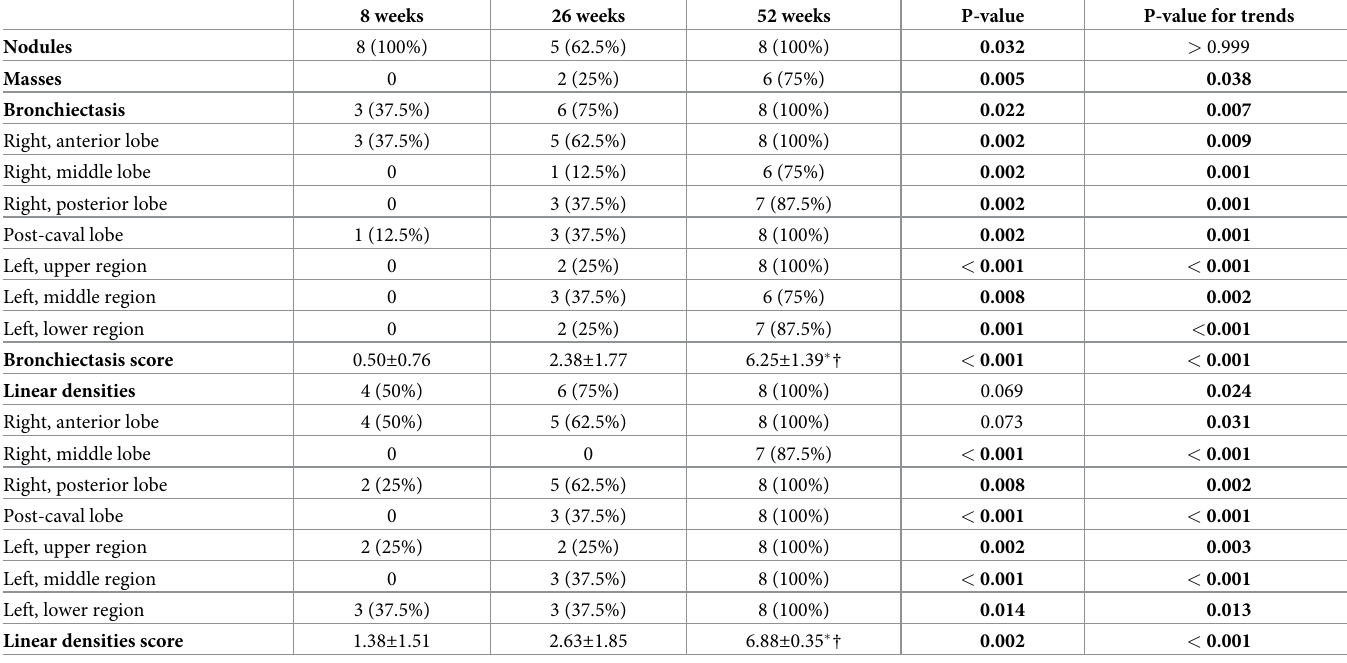
Table 4. Conventional chest CT image analysis 8, 26, and 52 weeks after PHMG